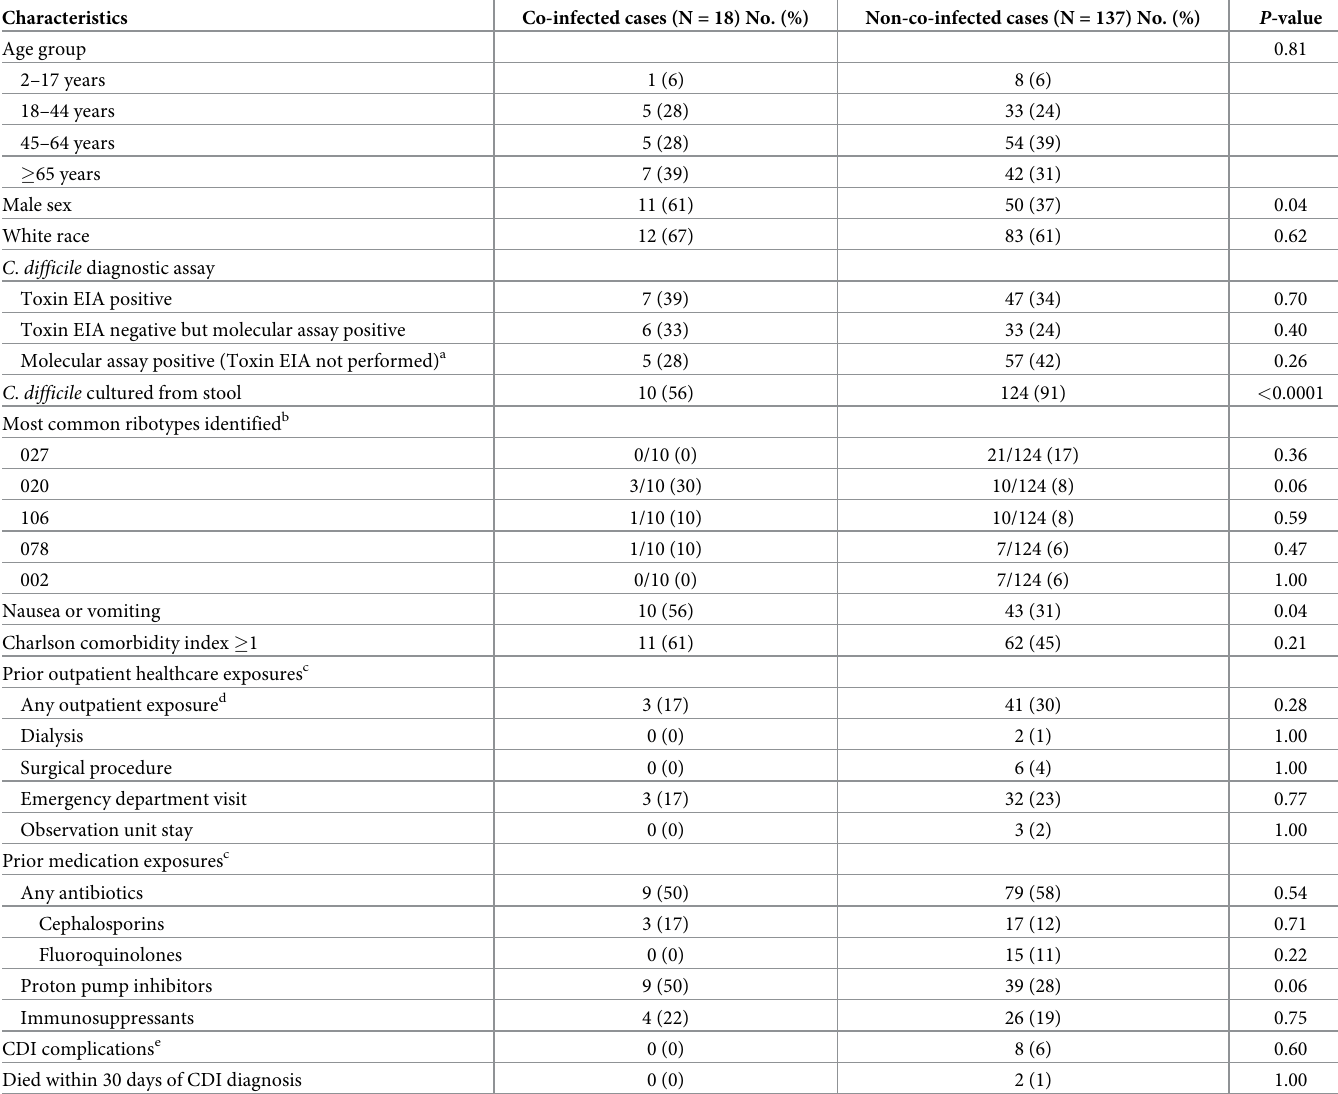
Table 1. Comparison of demographics, prior healthcare and medication exposures, and clinical characteristics between co-infected and non-co-infected commu- nity-associated Clostridioides difficile infection cases.